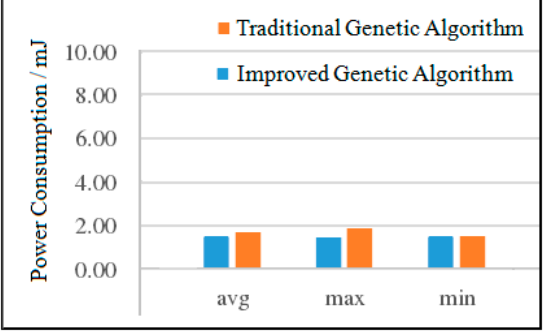
Figure 13. Comparison of the power consumption of the two algorithms for VOPD.